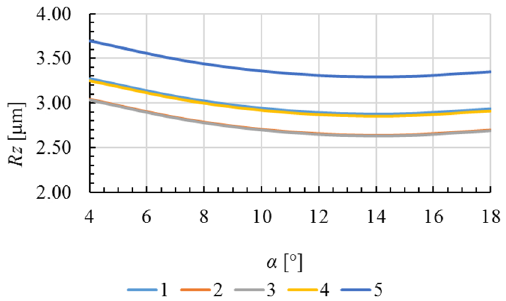
Figure 16. Effect of the curvature radius ρ 1 on the Rz roughness parameter in the machining of the convex surface: (1) α = 4°, (2) α = 7,5°, (3) α = 11°, (4) α = 14,5°, (5) α = 18°.